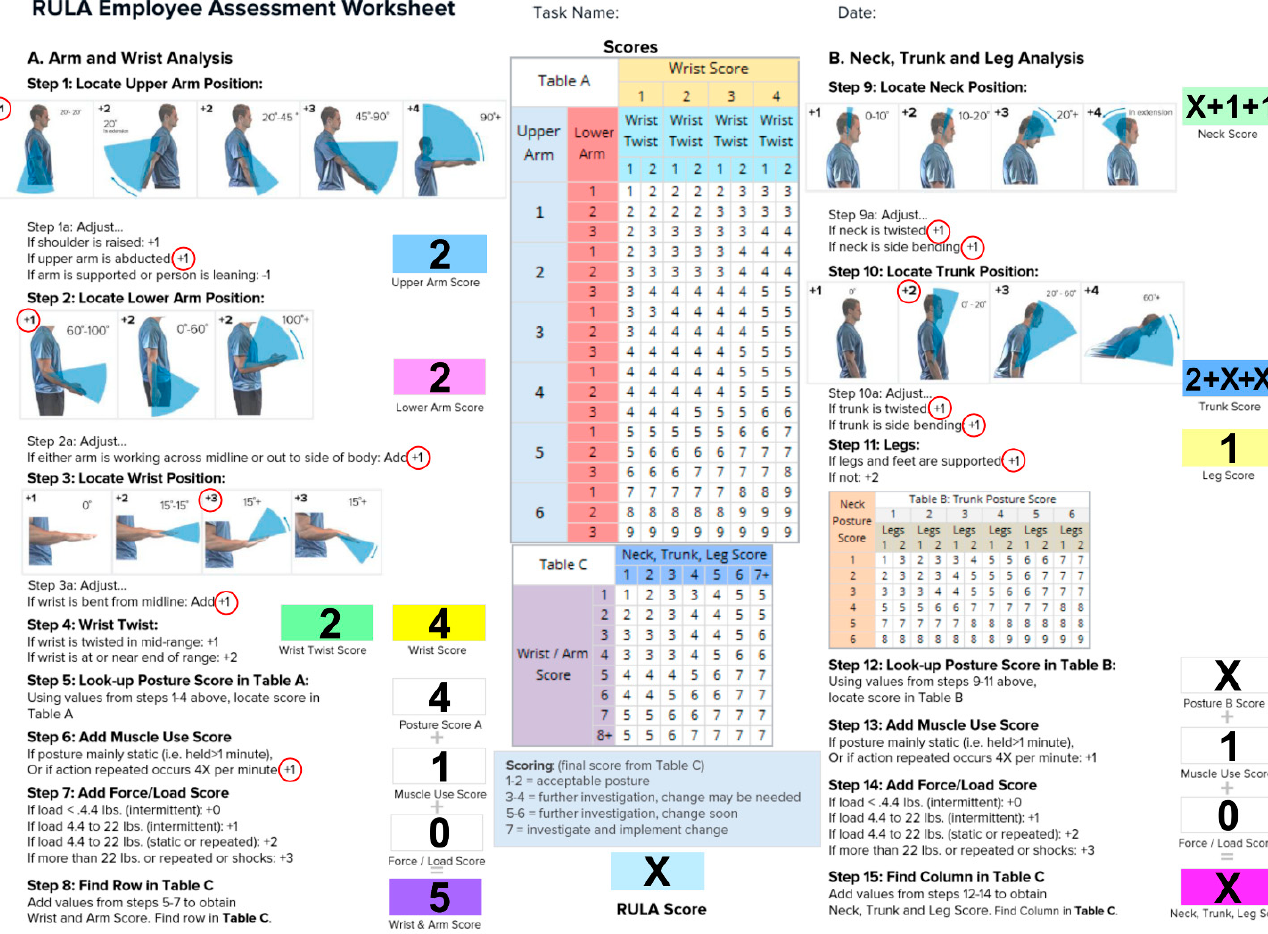
Figure 5. The filling sequence of a RULA form according to what is explained in the article (courtesy of ErgoPlus). The “X” represents values that, in our analysis, change according to the visual aid adopted. Further details in the text.